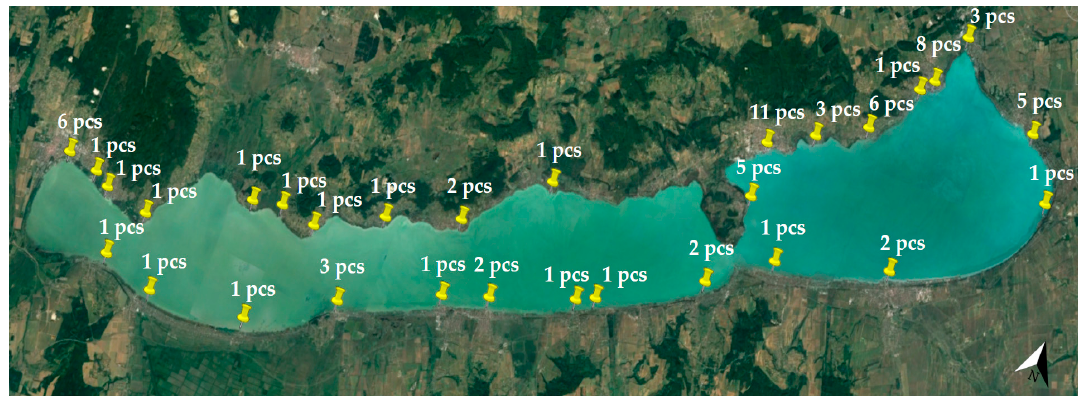
Figure 2. The number of sailing marinas per town/village at Lake Balaton, based on [55].